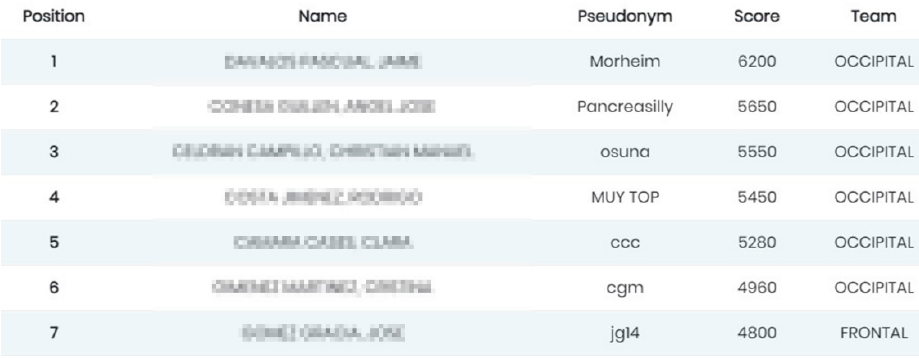
Figure 3. Individual Ranking of A Test.